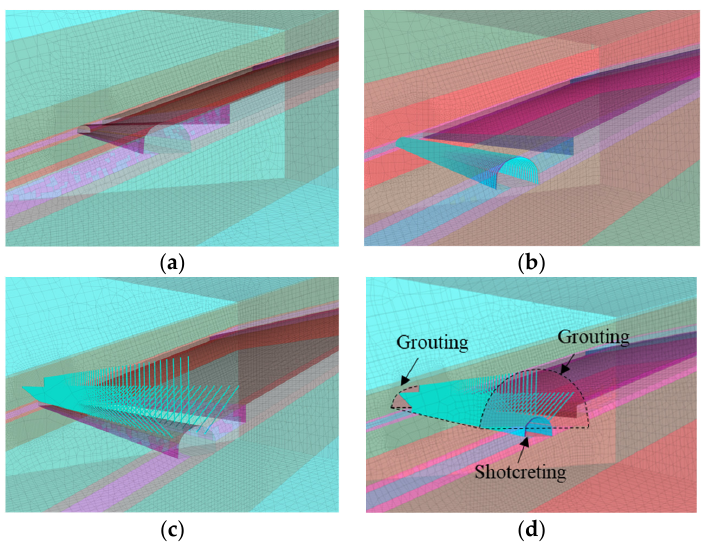
Figure 5. View of numerical model of four supporting methods. ( a ) No support, ( b ) U-shaped steel, ( c ) anchor cable, and ( d ) CUSG. Table 1. Micro-parameters for the strata.